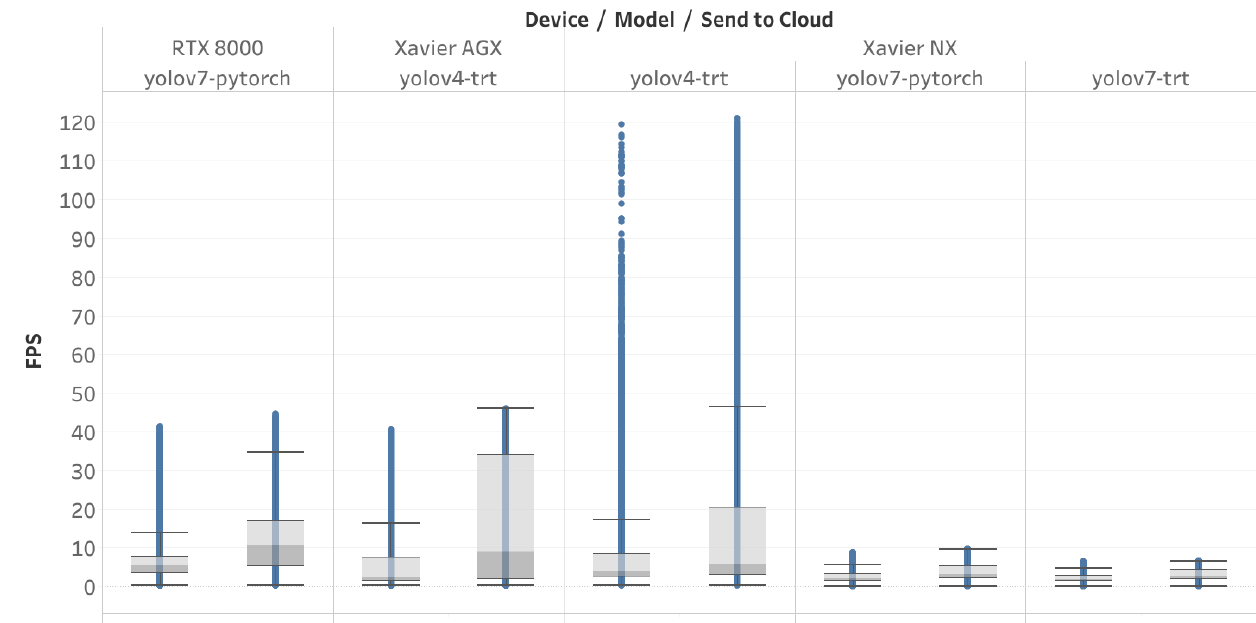
Figure 7. Inference speed per device, detection model, and video resolution.